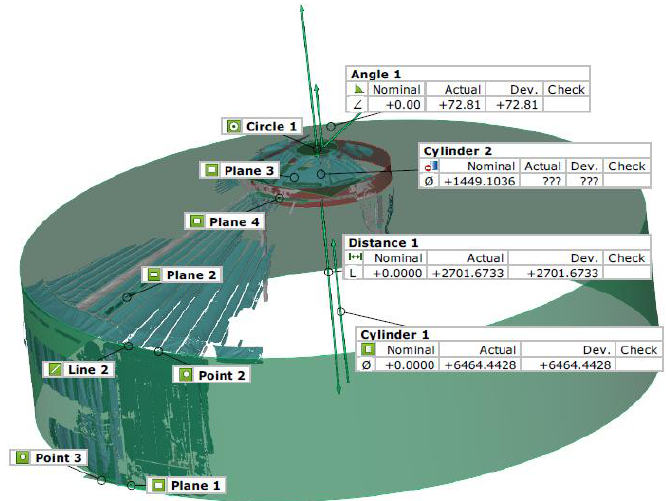
Figure 4. Measurement of the yurt’s volume using Creaform-HandySCAN Academy. Total floor area of the tested yurt is equal to 31.24 m 2 and its internal volume (above the elevated floor) is 54.68 m 3 .